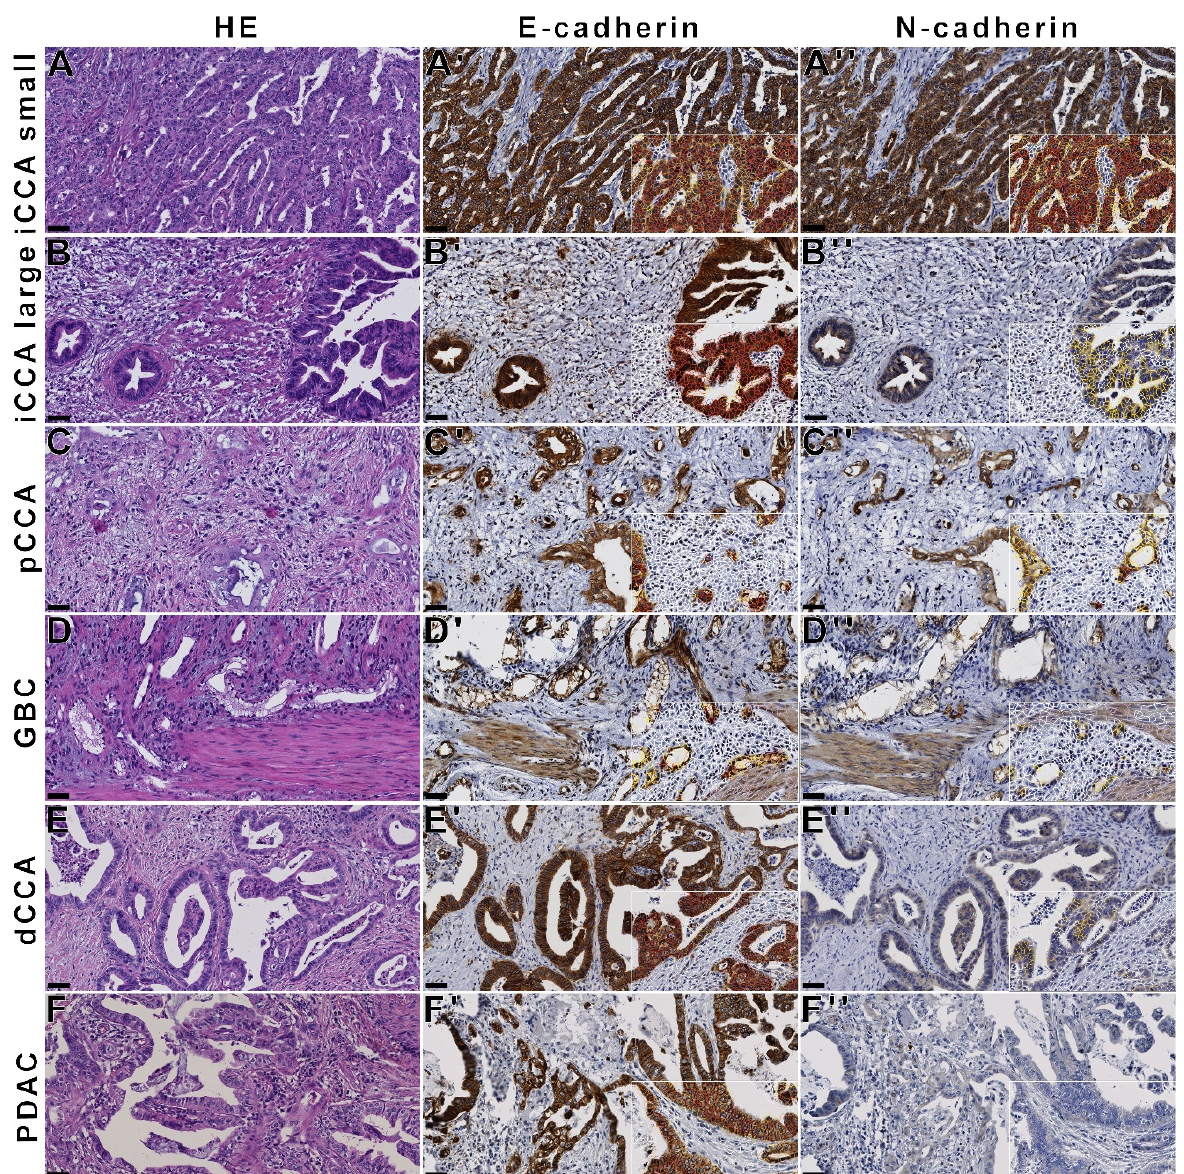
Figure 4. Stable E ‐ cadherin and differential N ‐ cadherin expression in carcinoma of the Figure 4. Stable E-cadherin and differential N-cadherin expression in carcinoma of the pancreato- pancreatobiliary tract. With immunohistochemistry, high N ‐ cadherin expression is detected in biliary tract. With immunohistochemistry, high N-cadherin expression is detected in iCCA ( A , B ) iCCA ( A , B ) and pCCA ( C ), whereas only faint N ‐ cadherin expression is detected in GBC ( D ) and and pCCA ( C ), whereas only faint N-cadherin expression is detected in GBC ( D ) and dCCA ( E ); no dCCA ( E ); no N ‐ cadherin is detected in PDAC ( F ) . In contrast, E ‐ cadherin is highly expressed in all N-cadherin is detected in PDAC ( F ) . In contrast, E-cadherin is highly expressed in all carcinomas of carcinomas of the pancreatobiliary tract. QuPath analysis on the bottom right ( A’ – F’ , A’’ – F’’ ). ( A’’ ): the pancreatobiliary tract. QuPath analysis on the bottom right ( A’ – F’ , A” – F” ). ( A” ): manual score 3, manual score 3, N ‐ cadherin H ‐ score 131.24; ( B’’ ) : manual score 2.5, N ‐ cadherin H ‐ score 80.40; ( C’’ ): manual score 2.5, N ‐ cadherin H ‐ score 132.65; ( D’’ ): manual score 2.0, N ‐ cadherin H ‐ score 64.18; ( E’’ ): N-cadherin H-score 131.24; ( B” ) : manual score 2.5, N-cadherin H-score 80.40; ( C” ): manual score 2.5, manual score 1.5, N ‐ cadherin H ‐ score 46.17; ( F’’ ): manual score 1.0, N ‐ cadherin H ‐ score 1.67. Cells N-cadherin H-score 132.65; ( D” ): manual score 2.0, N-cadherin H-score 64.18; ( E” ): manual score 1.5, with colored border: white—stromal cells, blue—tumor 0, yellow—tumor 1+, orange—tumor 2+, N-cadherin H-score 46.17; ( F” ): manual score 1.0, N-cadherin H-score 1.67. Cells with colored border: red—tumor 3+. Black bar: 50 μ m ( A – F , A’ – F’ , A’’ – F’’ ). white—stromal cells, blue—tumor 0, yellow—tumor 1+, orange—tumor 2+, red—tumor 3+. Black bar: 50 µ m ( A – F , A’ – F’ , A” – F”